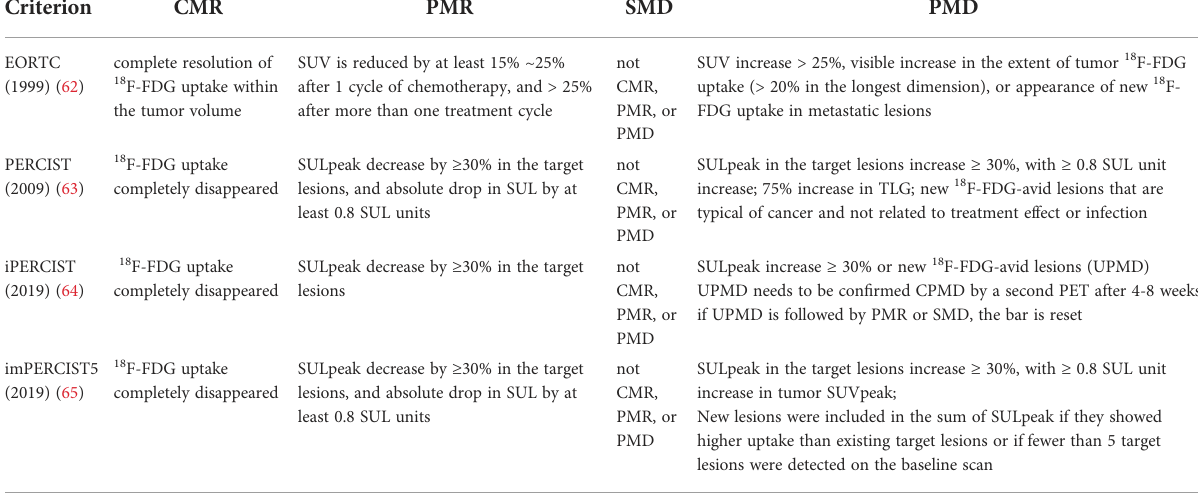
TABLE 2 Metabolism evaluation criteria for immunotherapy